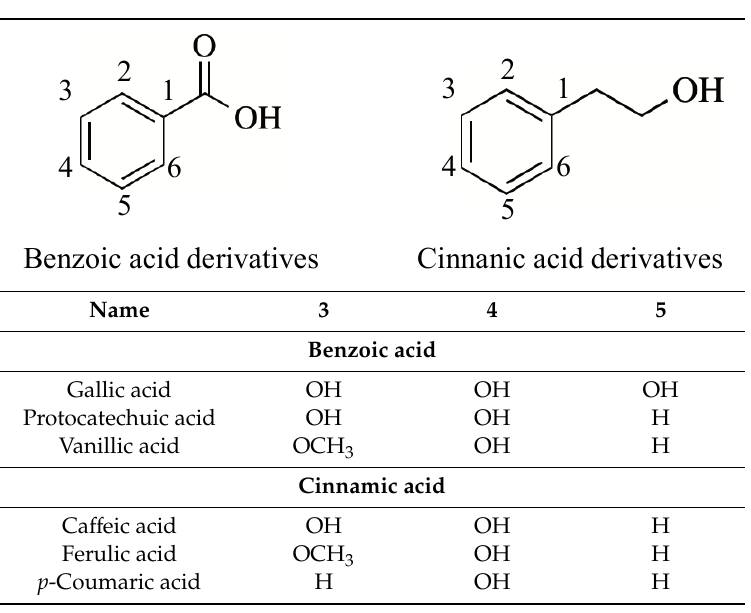
Table 2. Structures of phenolic acids.